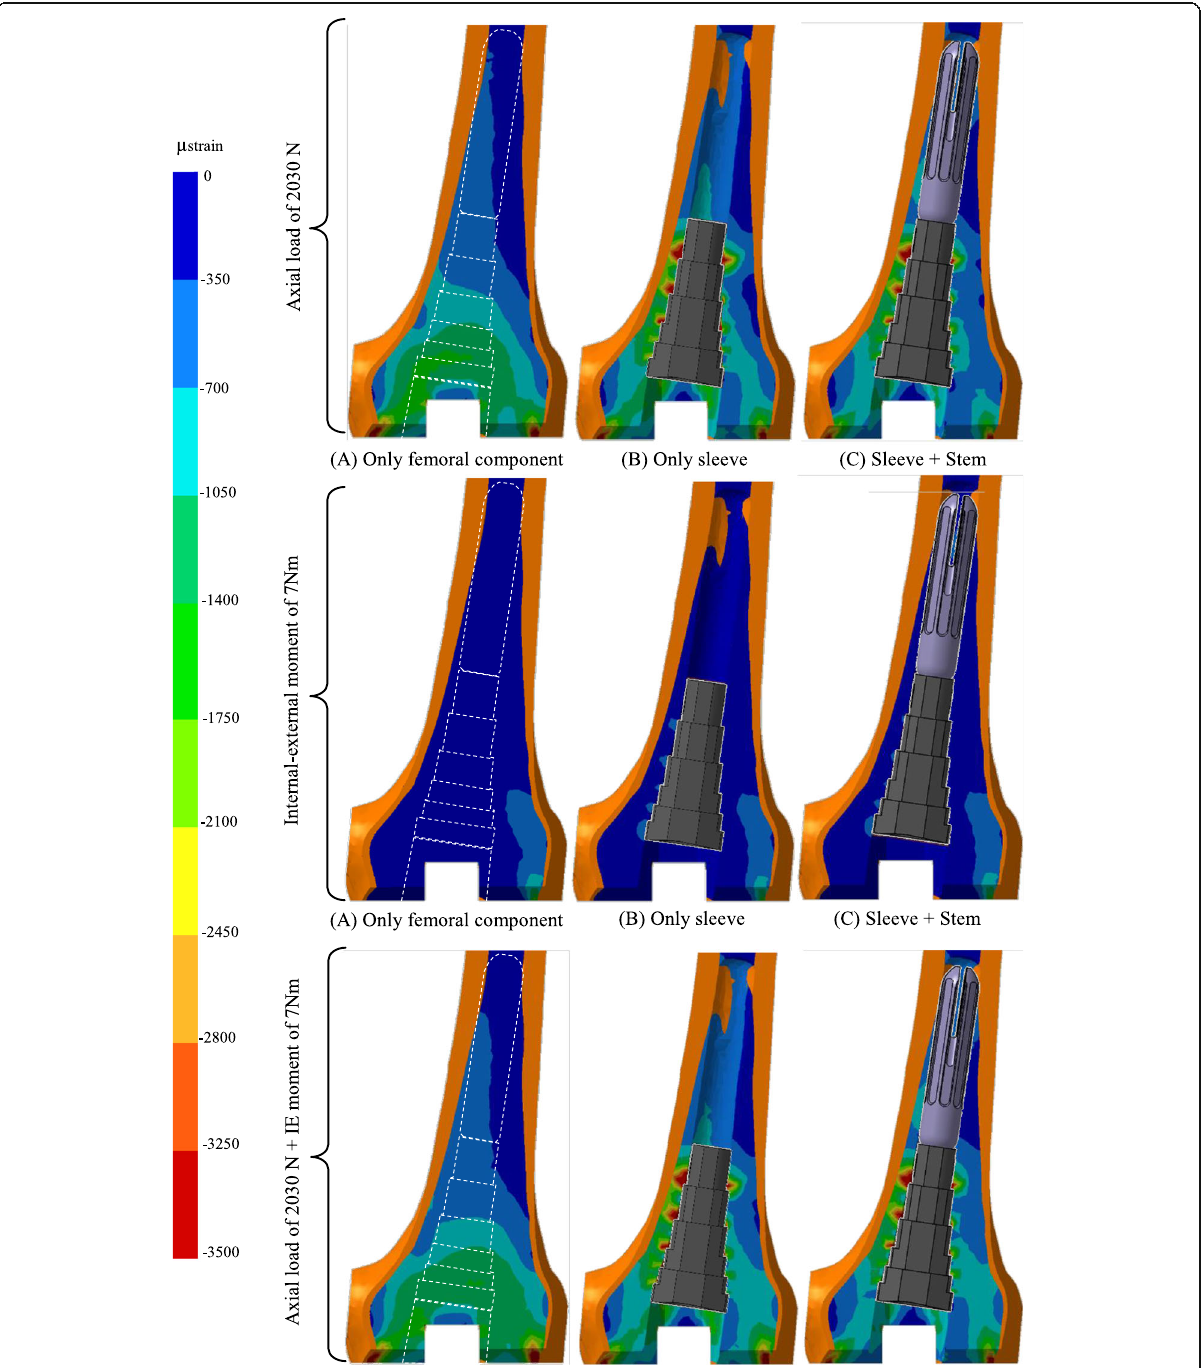
Fig. 5 Minimal principal strains in cancellous bone for the axial load case (upper row), internal-external moment load case (middle row) and axial load + internal-external moment load case (lower row) on the construct technique only with femoral component (left column), with sleeve (centre column) and with sleeve and stem (right column). The colour gradient specifies the range of principal